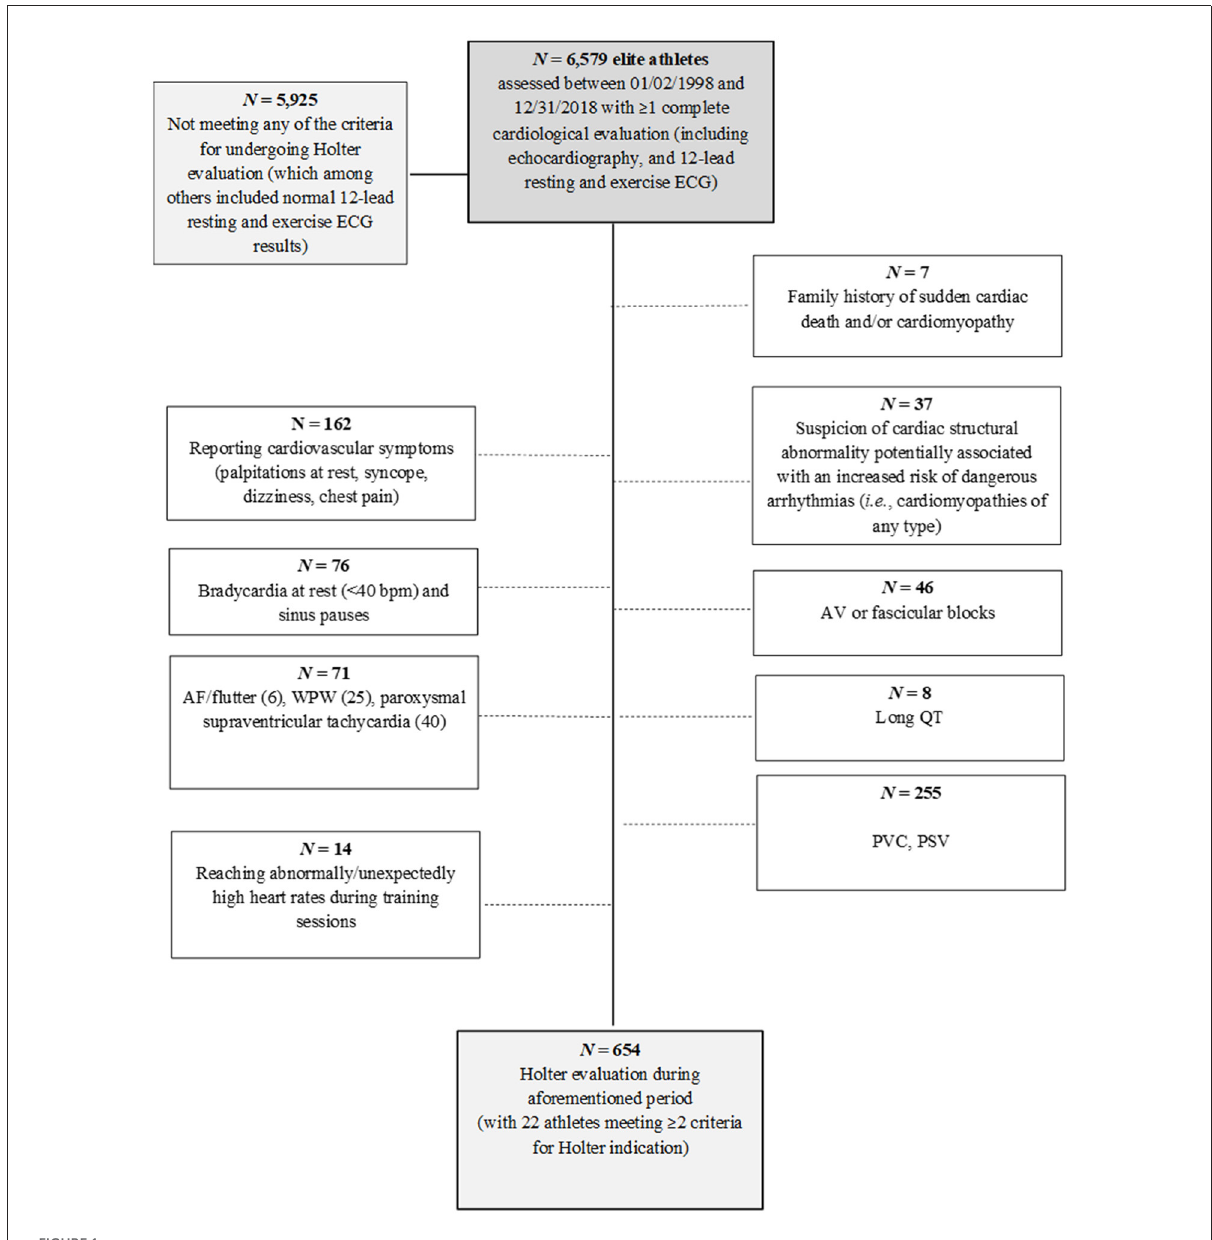
FIGURE1 Participant flow